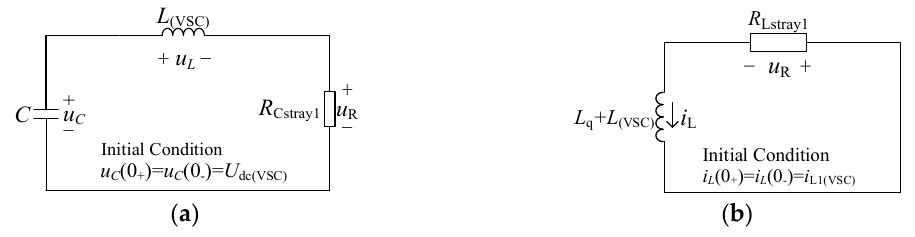
Figure 3. The first stage discharge circuit of VSC fault.